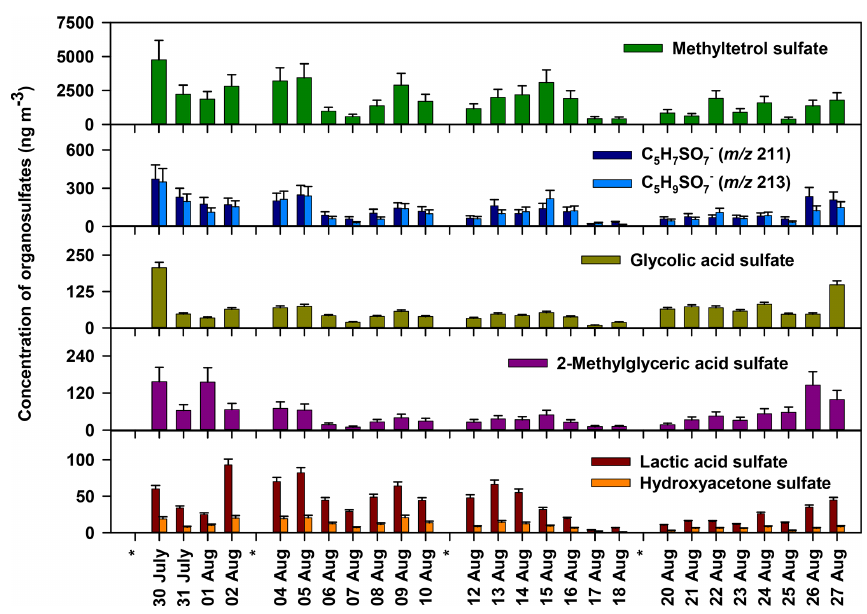
Figure 2. Time series of seven major organosulfate species quantified in August 2015 in Atlanta. Samples that were not analyzed (because they were used for a different purpose) are marked with a